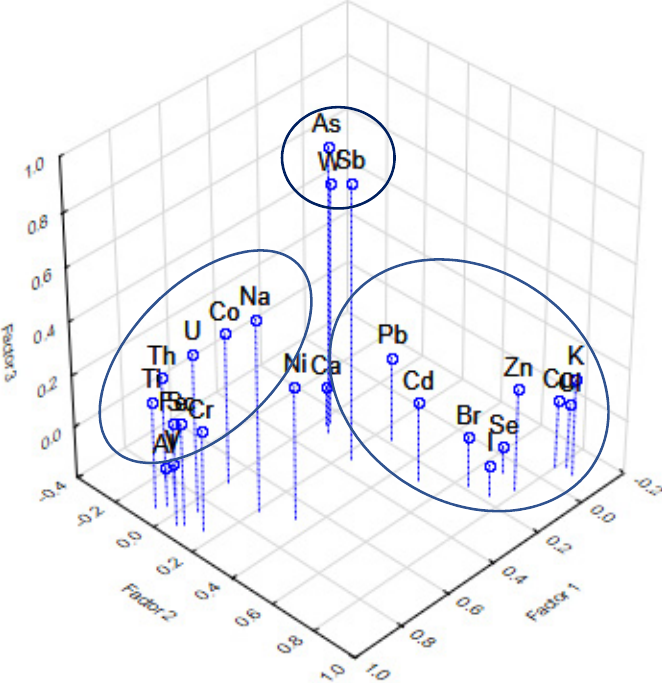
Figure 4. Factor Loadings, Factor 1 vs. Factor 2 vs. Factor 3. Rotation: Varimax normalized. Extraction: Principal components.